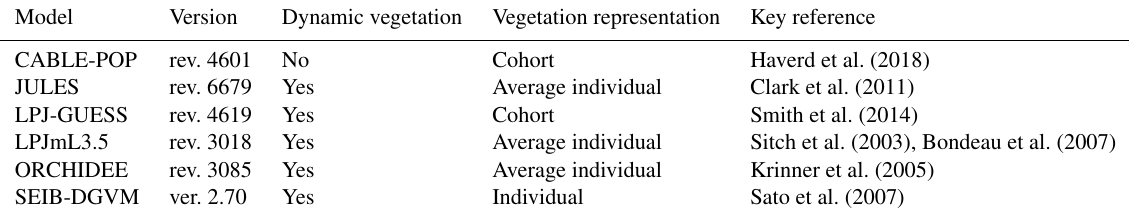
Table 2. Models included in this study.